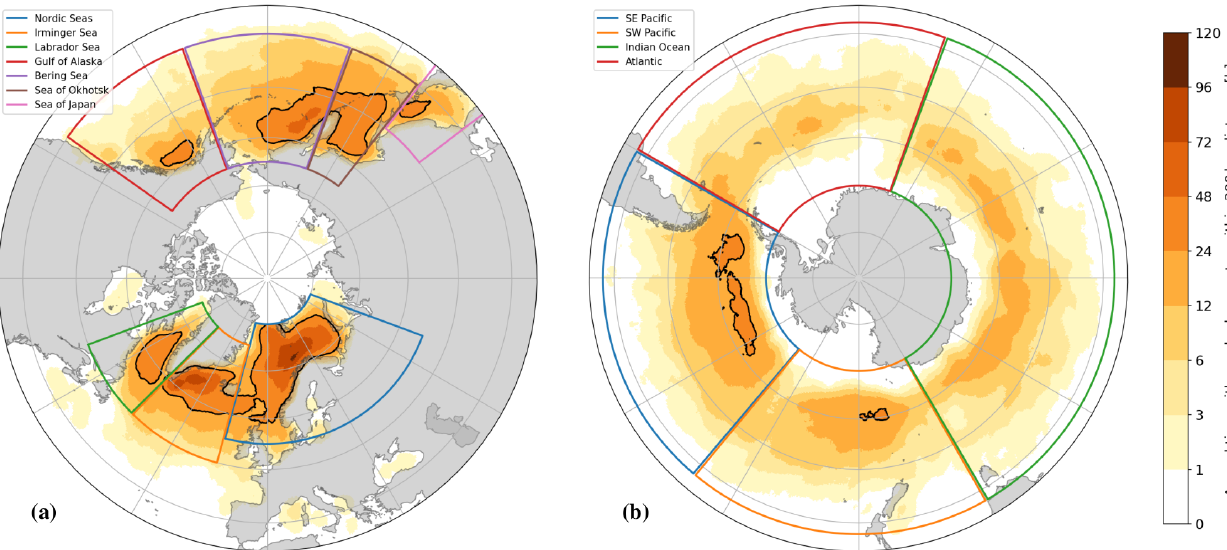
Figure 3. Annual mean density of polar-low activity, measured by the amount of polar-low time steps within a 200km distance, which is a typical radius of a polar low, for (a) the Northern Hemisphere and (b) the Southern Hemisphere. Note the logarithmic colour scale towards low densities. A black contour encircles regions with activity of more than 24hyr − 1 , which means that a given location is affected by a polar low with a typical duration of 1d approximately once per